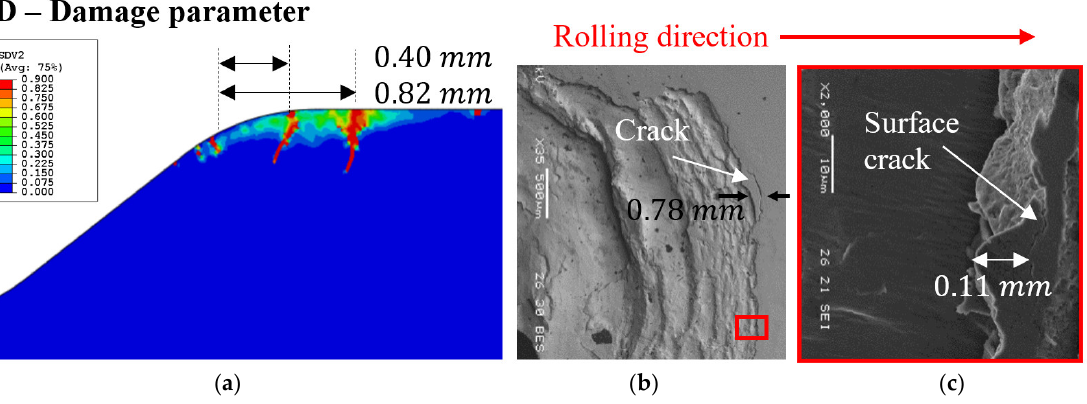
Figure 8. ( a ) Map of the damage variable, D, represents the crack generation within the spall edge, where the maximum residual stress uses as the effective stress. ( b ) SEM images of the spall